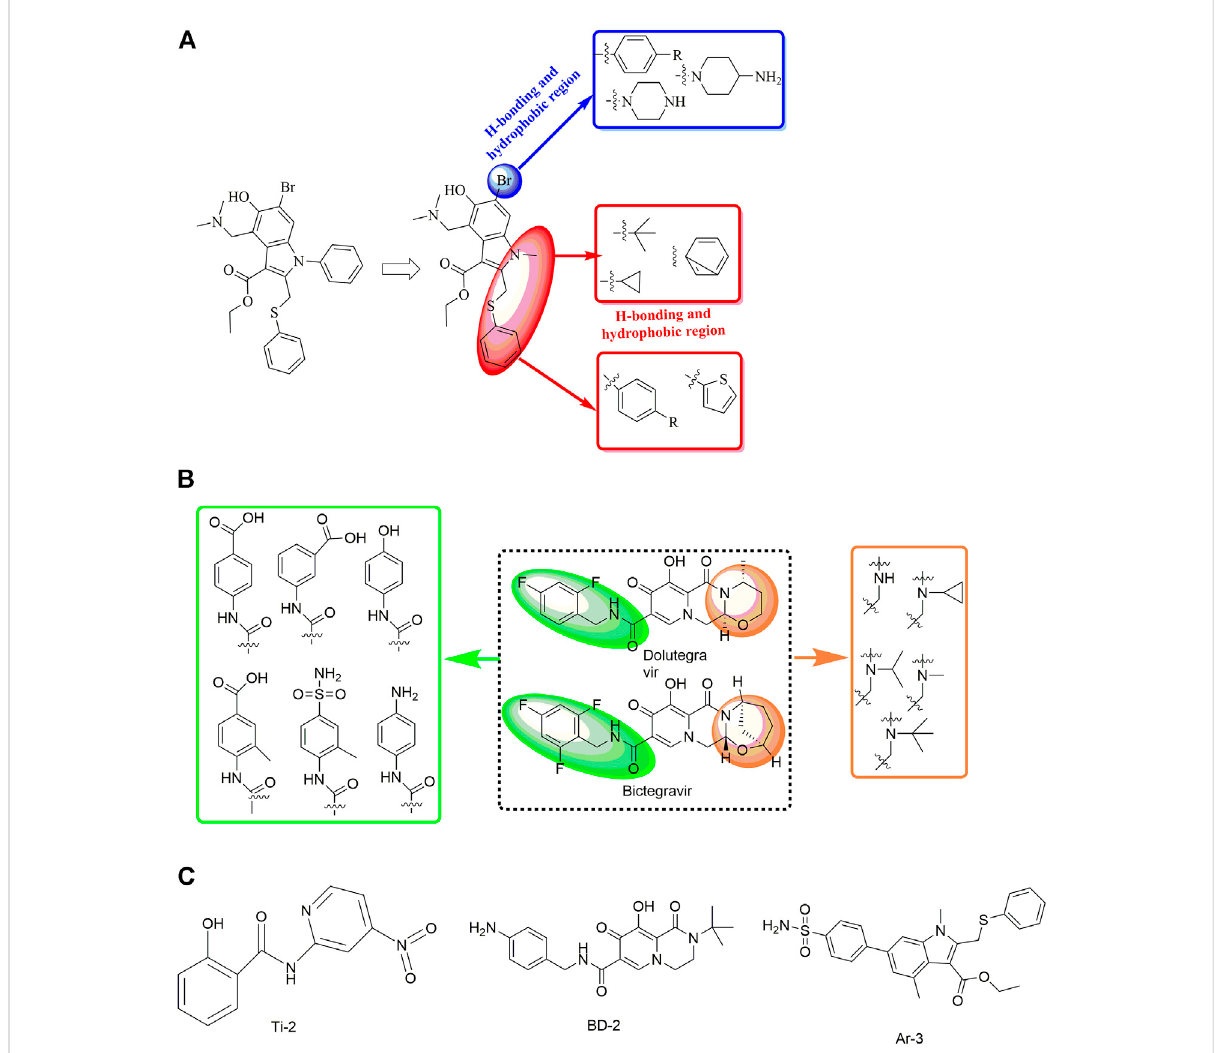
FIGURE 12 Strategies for the further structural optimization of arbidol (A) , dolutegravir and bictegravir (B) and the structures of BD-2, Ti-2 and